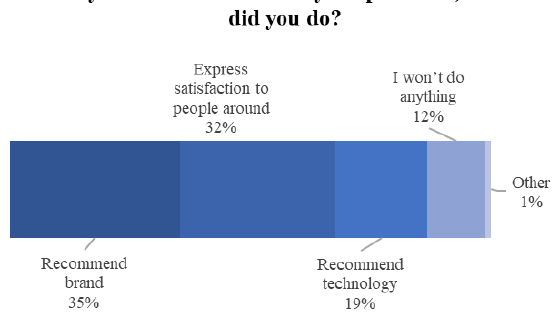
Figure 12. Post-purchase attitude in case of satisfaction.